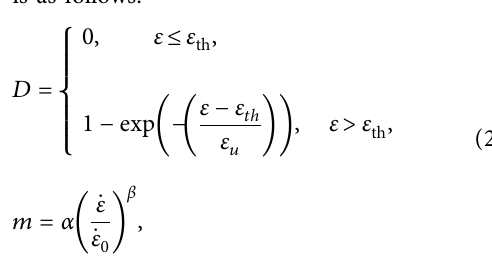
Table 2: Parameters of damage evolution